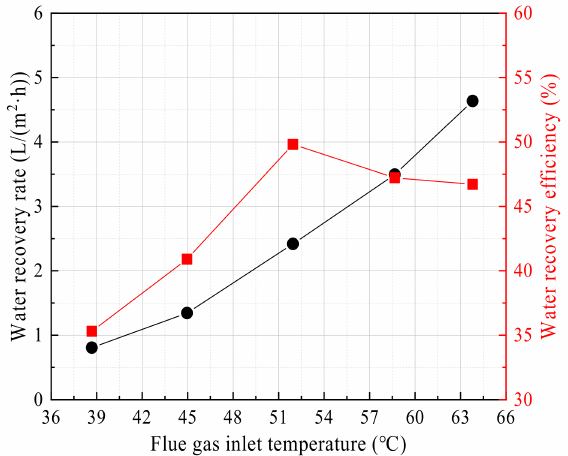
Figure 13. Water recovery rate/efficiency vs. Flue gas temperature. Experiment conditions: flue gas flow 9.85 L/min, negative pressure airflow 15 L/min, negative pressure air inlet temperature 12.95 ◦ C, membrane pore size 10